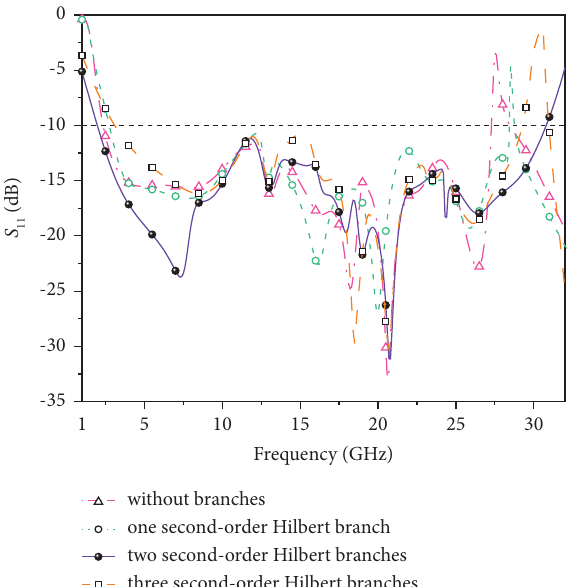
Figure 5: S 11 results in the addition of the branch and for diferent numbers of